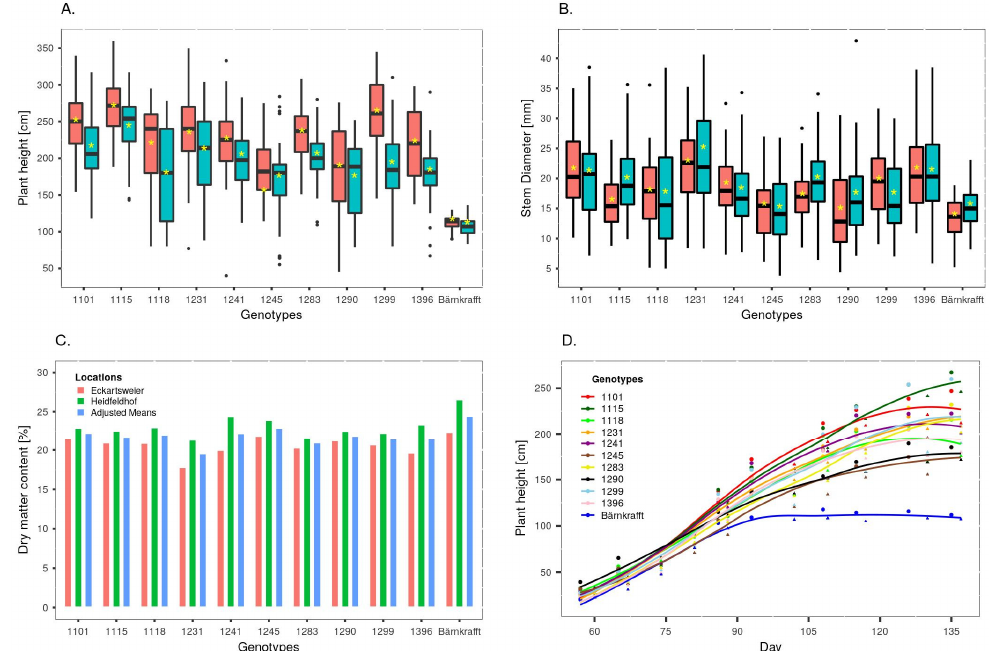
Figure 2. Box plots of genotypes for ( A ) plant height and ( B ) stem diameter, based on individual plant observations across three blocks per location. Red and turquoise colors indicate Eckartsweier and Heidfeldhof, respectively. Yellow asteriks indicate location-specific least square means of the genotypes. ( C ) Bar plot of dry matter content. Red and green colors indicate location-specific least square means of the genotypes from Eckartsweier and Heidfeldhof, respectively. Blue color indicates the adjusted least square means estimated over both locations. ( D ) Repeated measurements of plant height based on both locations. Dot and triangle point shapes represent Eckartsweier and Heidfeldhof, respectively. Each observation point indicates the mean value of a genotype based on the labeled individuals over three blocks, whereas the corresponding value of an observation point on the X axis indicates the observation day. The graph was generated using local weighted polynomial regression model